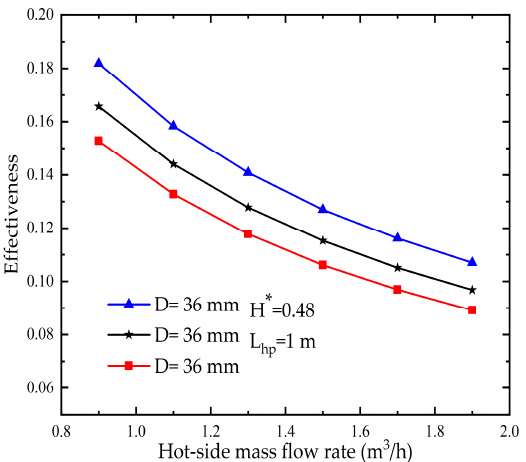
Figure 11. Comparison of effectiveness with different HP diameters. (The mass flow rate at cold side of the HPHEX is 2.9 m 3 /h.)